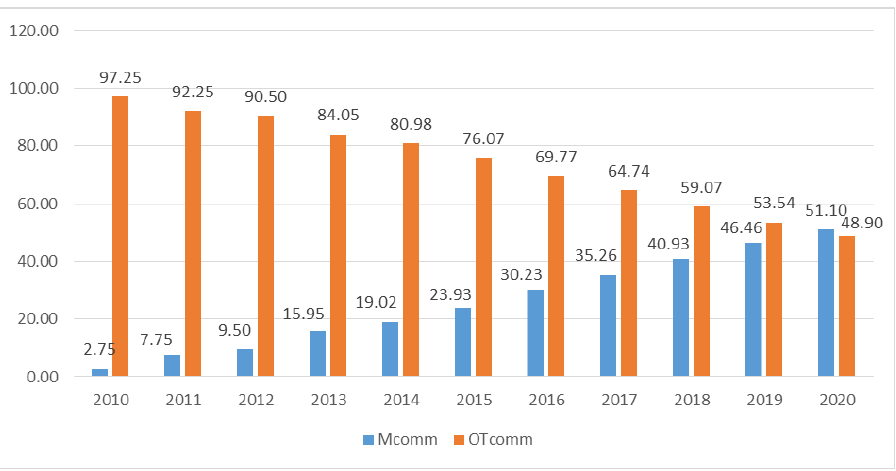
Figure 1. Comparative evolution of m-commerce and other tools of commerce. Source: developed by authors.